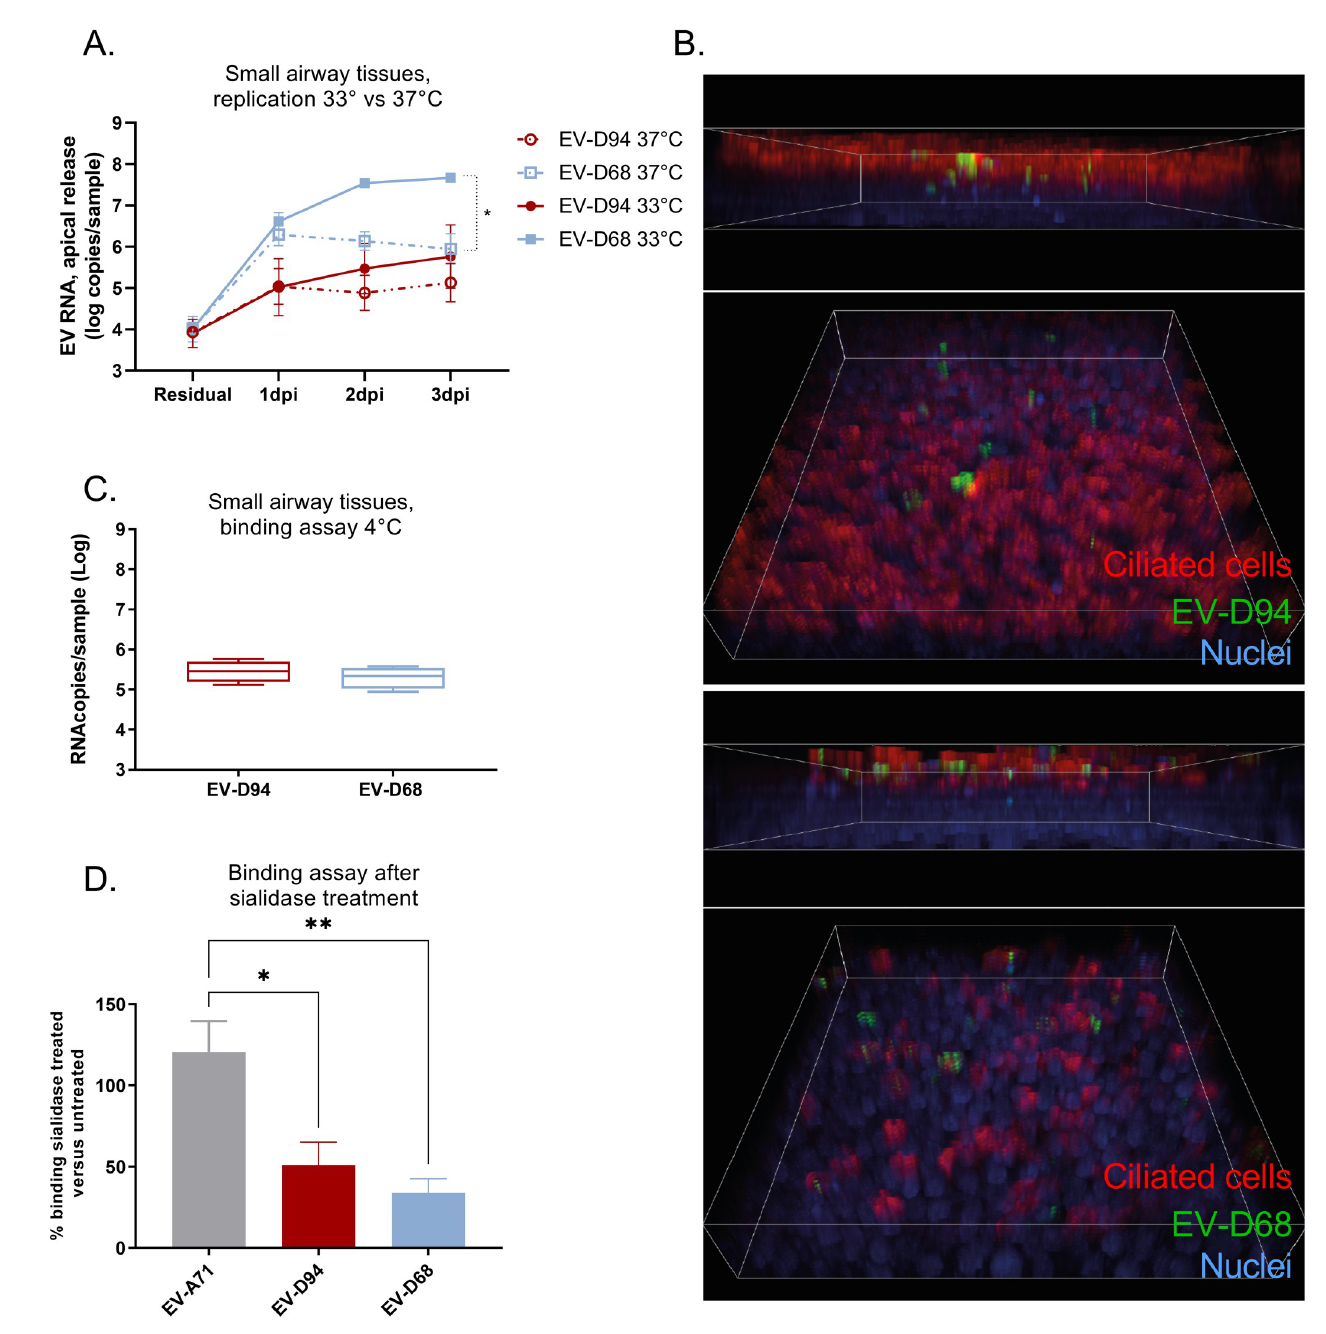
Fig 2. Differential replication of EV-D94 and EV-D68 in respiratory tissues. A) Viral replication at 33˚C and 37˚C. Viral replication was quantified as in Fig 1A and 1B) 3D projections of confocal images of infected respiratory tissues at 1dpi. Nuclei were stained with DAPI (blue), viral RNA with J2 antibody (green) and ciliated cells with anti-beta IV tubulin antibody (red). Images were acquired in the same area at different z-stacks and 3D projections (with apical tissue side on top) were generated with Imaris. The corresponding 2D images are available in S2 and S3 Figs with co-staining of virus and ciliated or basal cells respectively. C) Binding assay. Tissues were infected 1h 4˚C, washed extensively and viral loads were quantified in tissue lysates by RT-qPCR. D) Binding assay in tissues pretreated or not with sialidase. Tissues were washed 3 times with PBS and incubated for 1h at 37˚C with sialidase or with control buffer. After extensive washing, binding assay was run as in C. Treated and untreated tissues were processed in parallel for sialic acid staining (S4 Fig).